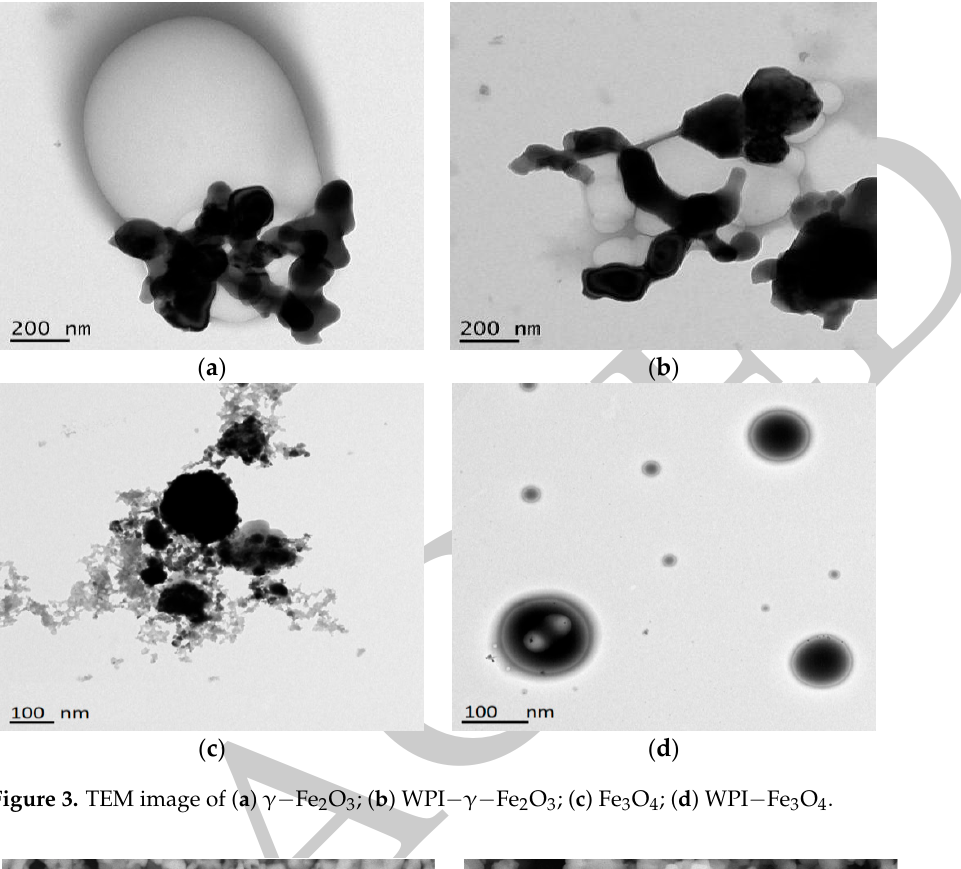
Figure 3. TEM image of ( a ) γ− Fe 2 O 3 ; ( b ) WPI −γ− Fe 2 O 3 ; ( c ) Fe 3 O 4 ; ( d ) WPI − Fe 3 O 4 .